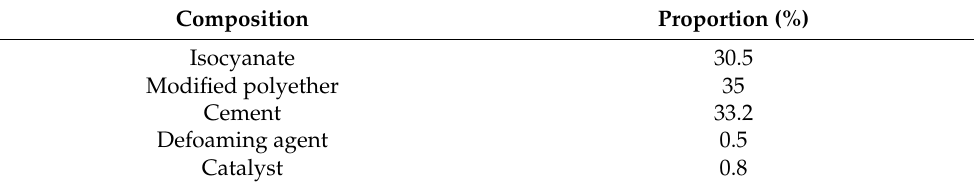
Table 1. Composition and mass proportions of polyurethane cement